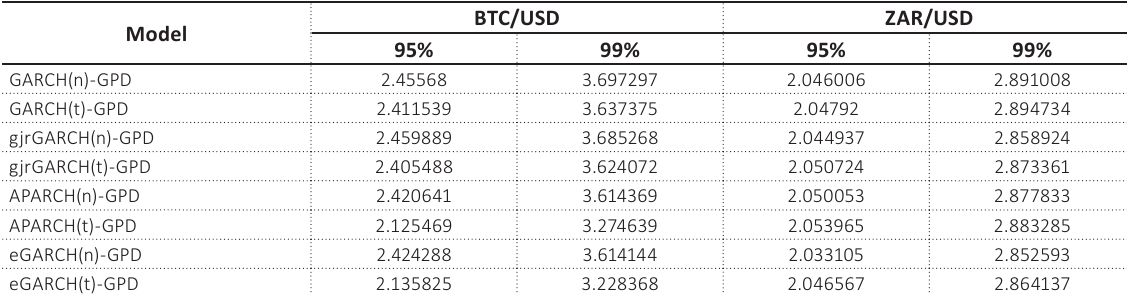
Table 6. ES estimates using fitted hybrid GARCH(1,1)-GPD